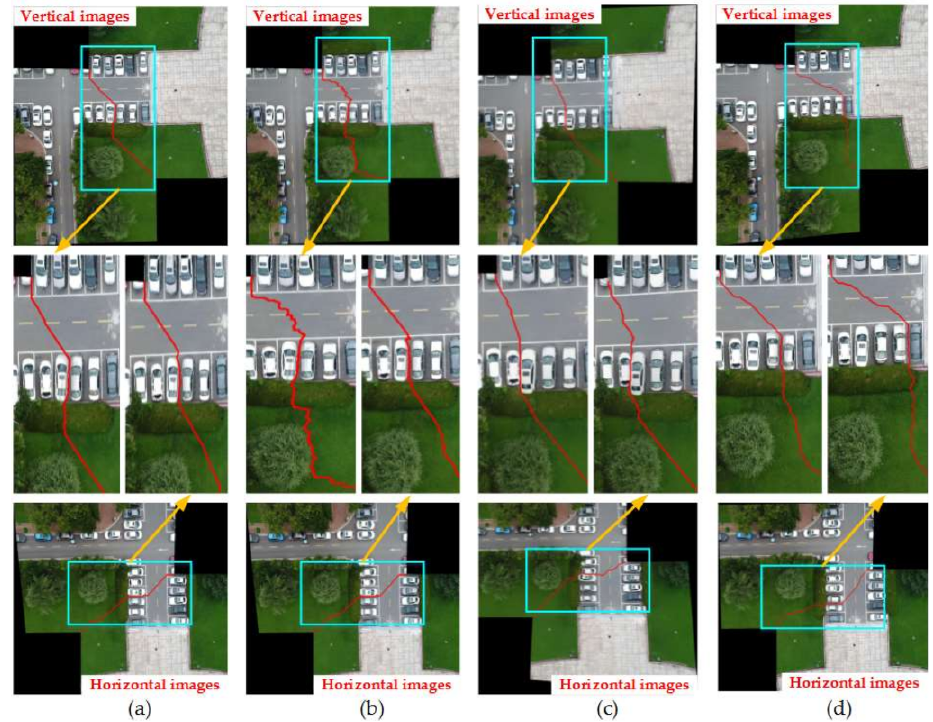
Figure 13. The seam-lines of four search methods for Figure 7b: ( a ) Dulapquet3-DP; ( b ) Dulapquet4-DP; ( c ) OpenCV-DP; ( d ) Our-Flow-DP.